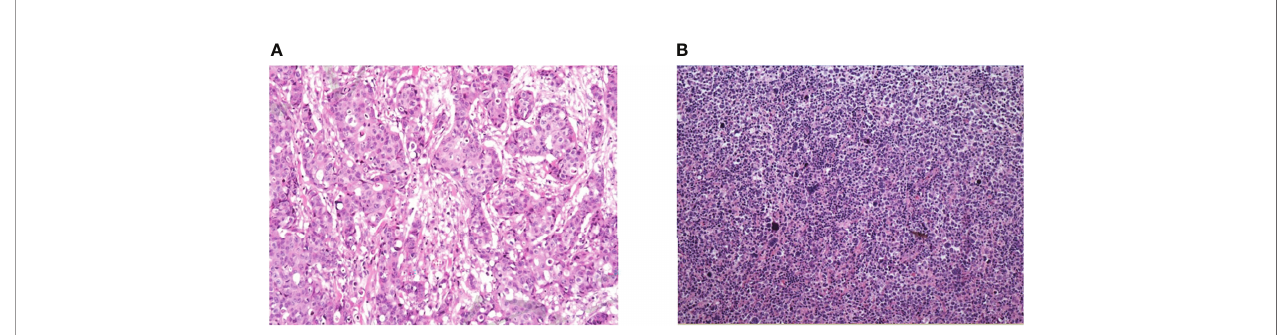
FIGURE 1 | Pathological results of breast cancer and primary breast lymphoma. (A) Female, 47, diffuse large B-cell lymphoma. Microscopically, large tumor cells were diffusely in fi ltrated and homogeneous in shape. Immunohistochemistry: CD20(++), PAX-5(+), CD5(+), Bcl-6(-), CD10(-), Mum-1(-), Ki-67(index 80%). (B) Female, 65, invasive breast cancer (non-speci fi c, moderately differentiated), microscopically large tumor cells with invasive growth and acinar distribution, obvious atypia and mitotic visible. Immunohistochemistry: Her-2 (3+), CD10(-), PR(-), CgA(-), Syn(-), P53(+), Ki67 (index 70%).